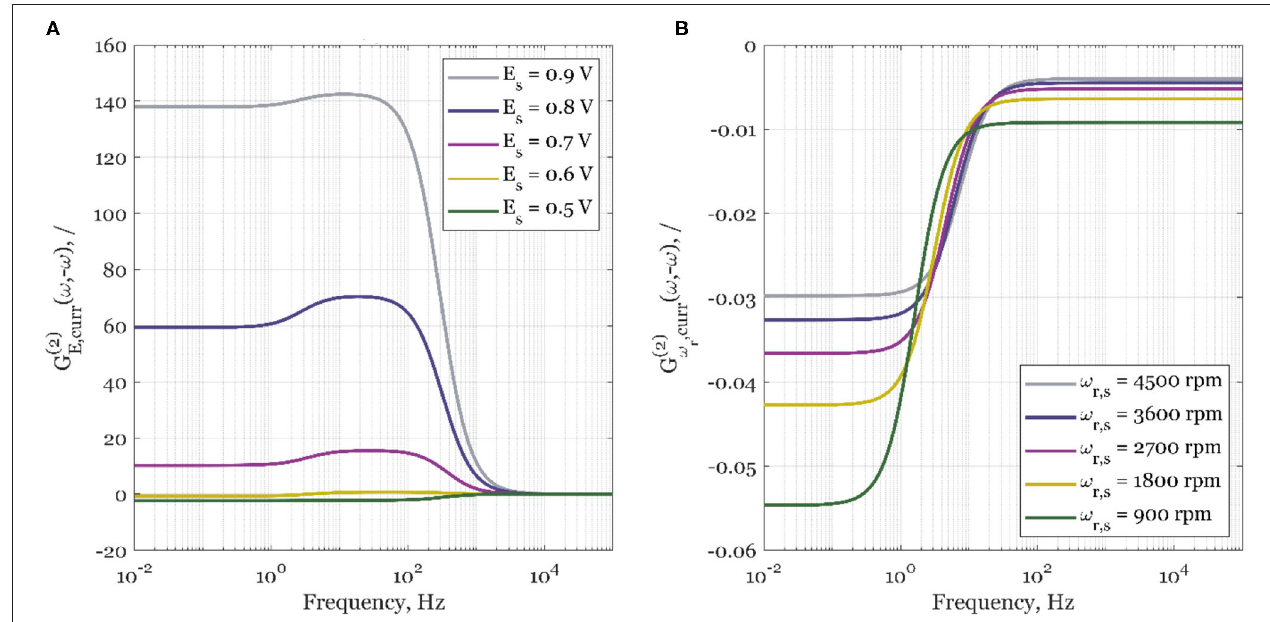
FIGURE 3 | The simulated second-order asymmetrical FRFs for the current density, curr , as the output, and (A) electrode potential, E , as the periodically changed input, and steady-state rotation rate 1,600 rpm; (B) electrode rotation rate, ω r , as the periodically changed input, and steady-state potential